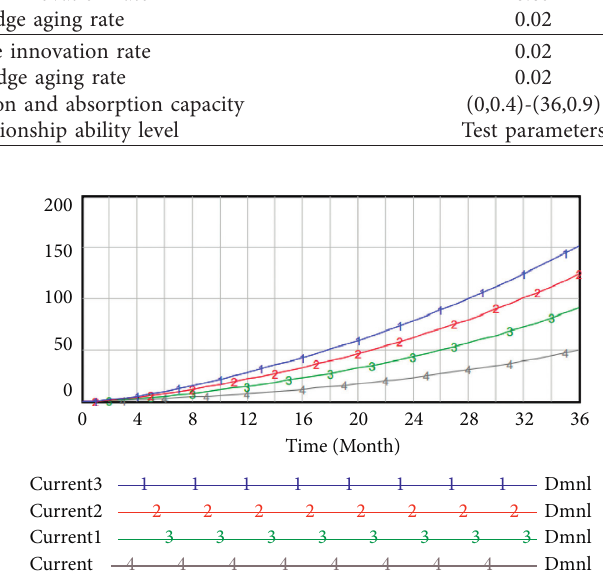
Figure 4: Simulation diagram of the relationship between network relationship capability and knowledge storage of the knowledge receiver.